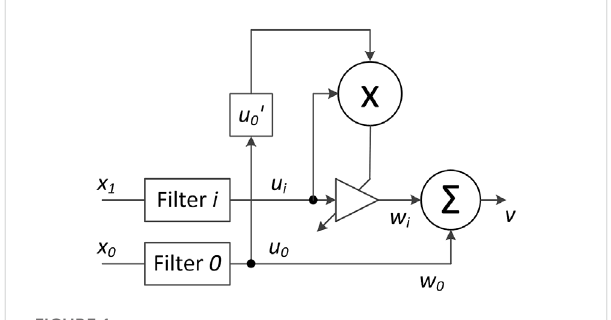
FIGURE 1 Illustration of the ICO learning model. The raw stimulus input x 1 can trigger many different activation signals u i , which depend on the fi lters ’ properties. The signal x 0 acts as a reference that changes the synaptic weights w i in an unsupervised